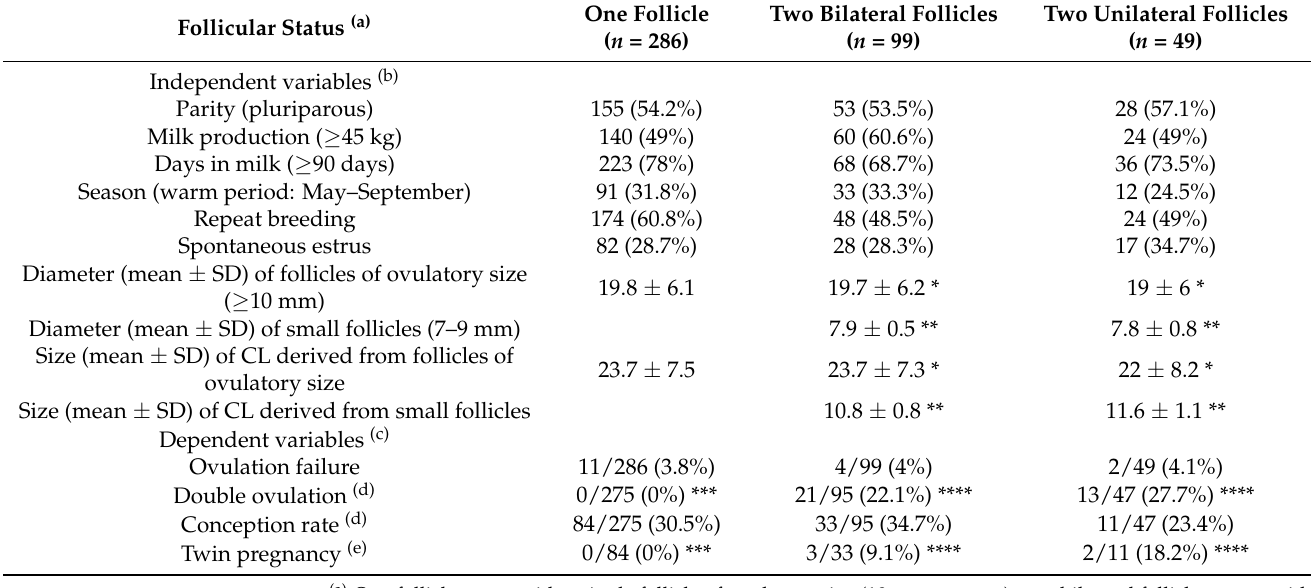
Table 1. Independent variables recorded at the time of AI and effects of the three ovulatory follicle states on each dependent variable ( n = 434).